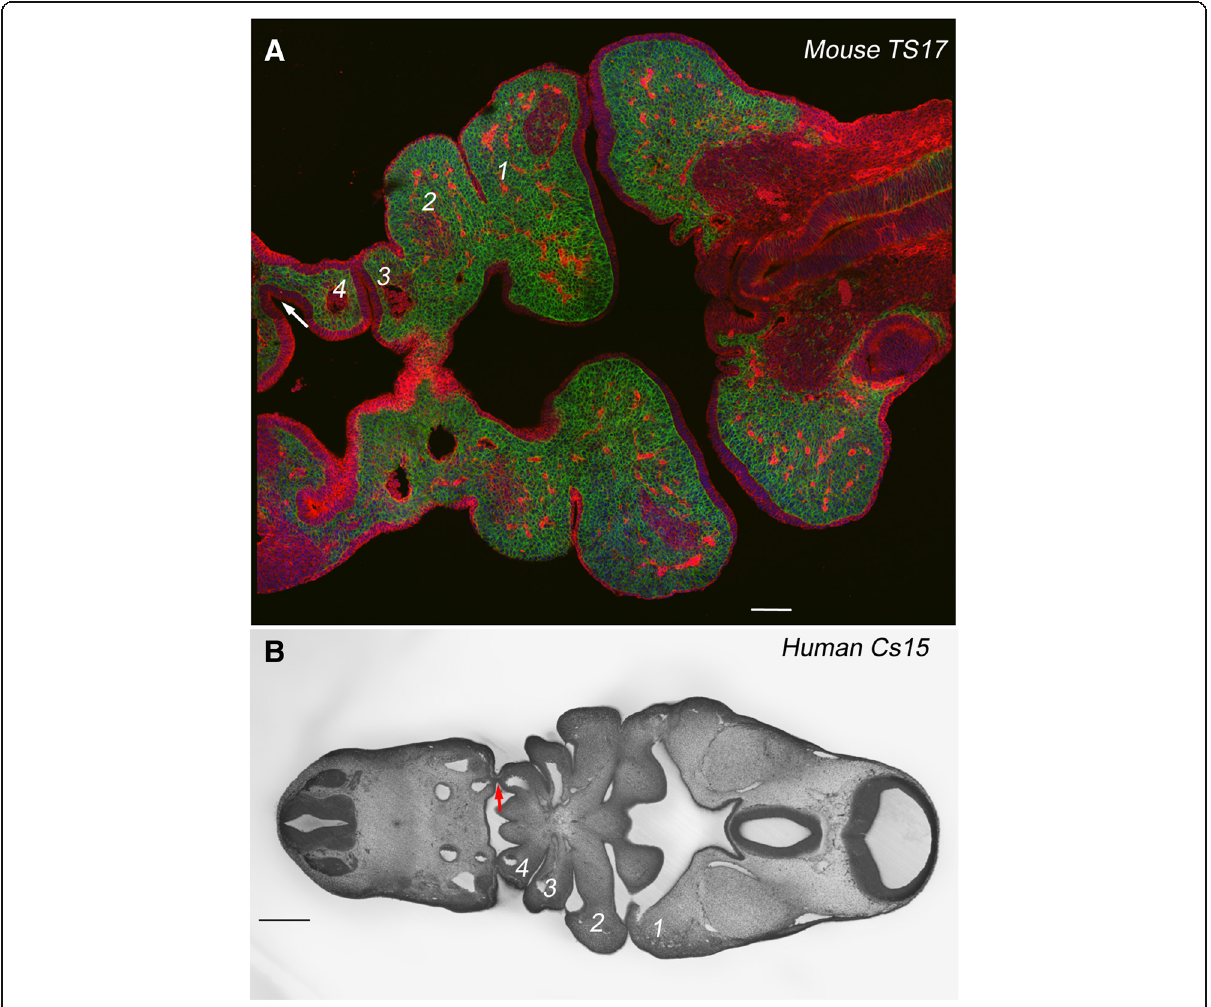
Fig. 5 Pharyngeal pouch morphology in mouse and human embryos. a Confocal section through the pharyngeal region, at the segmental phase, of a TS17 (E10.5) mouse embryo. Neural crest ( Wnt1::cre+ ) structures are labelled with membrane GFP, while non-neural crest tissues express membrane RFP. It is noticeable that the fourth pouch, highlighted by an arrow, does not contact the ectoderm. b HREM section through the pharyngeal region, at the segmental phase, of a CS15 human embryo. The fourth pouch, highlighted by an arrow, does contact the ectoderm. Scale bar = 0.25